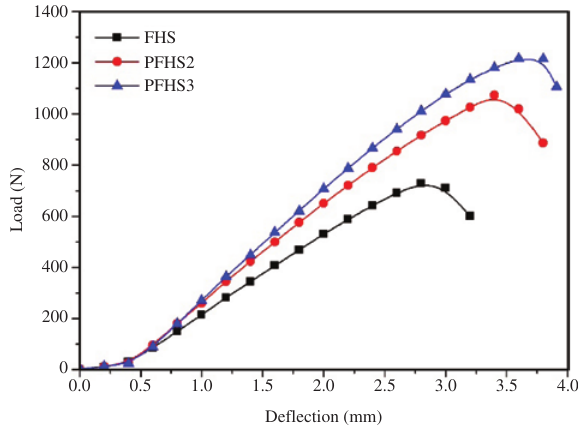
Figure 12: Load-deflection curves of sandwich panels subjected to flexural